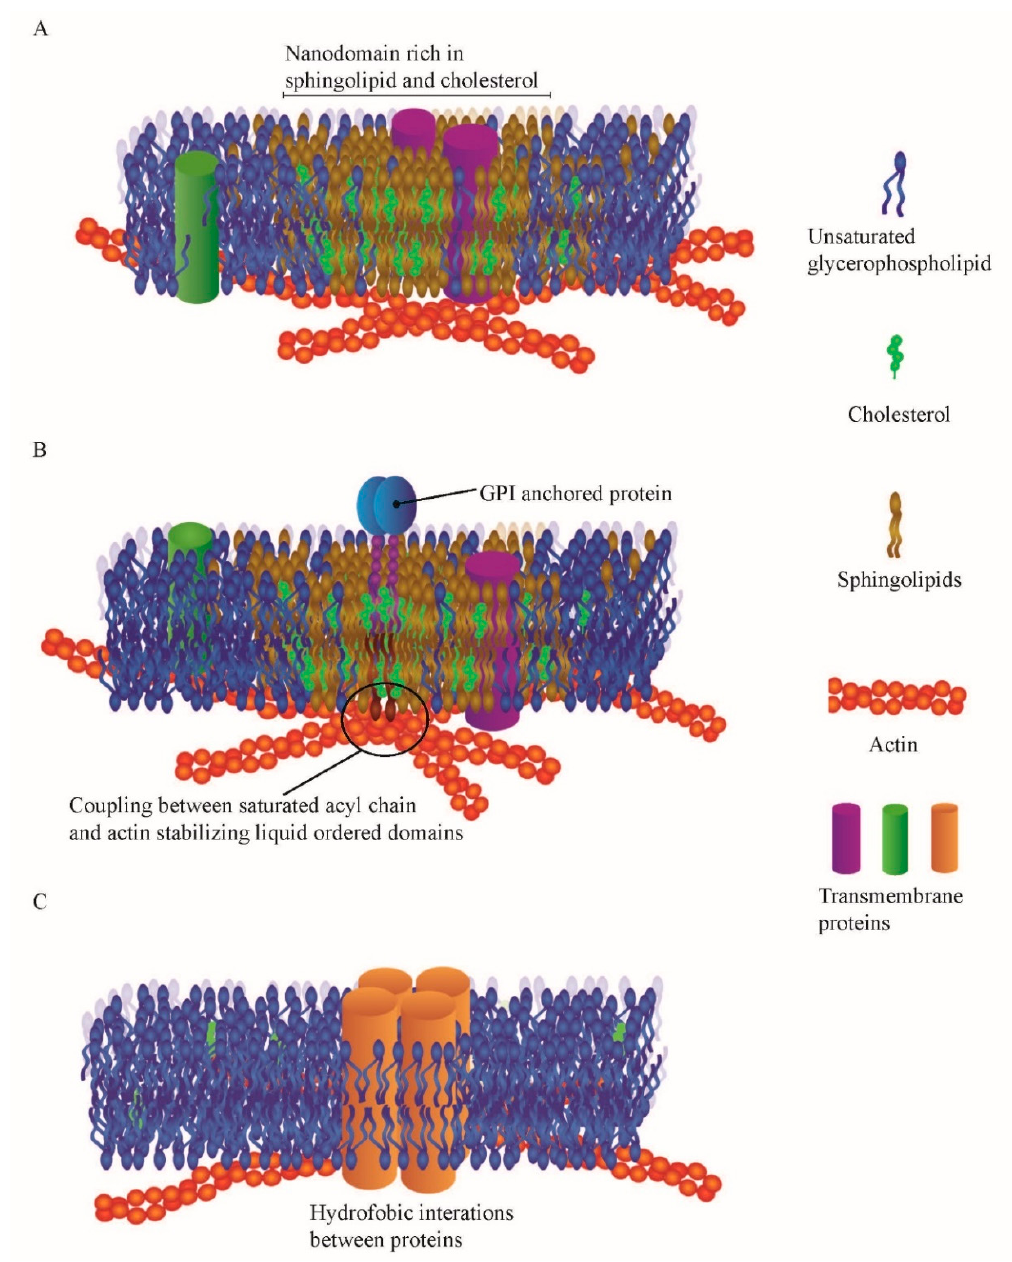
Figure 1. Illustration of the different types of nano ‐ domains in the hierarchal model. ( A ) Illustrates the proteolipid nano ‐ domains, which are stabilized by increased concentrations of sphingolipids and cholesterol. ( B ) Shows the actin anchored nano ‐ domains which are coupled to the underlying actin network. ( C ) Illustrates protein oligomerization that can also appear as nano ‐ domains.